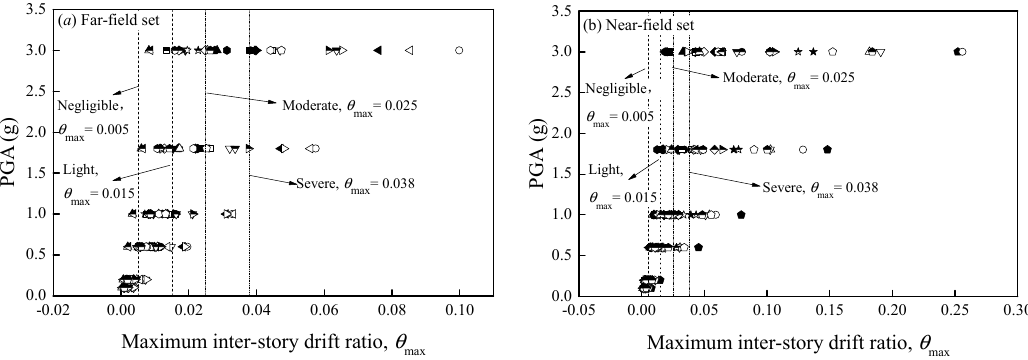
Figure 3. Maximum interstory drift ratios θ max obtained at six IM levels in both record sets.